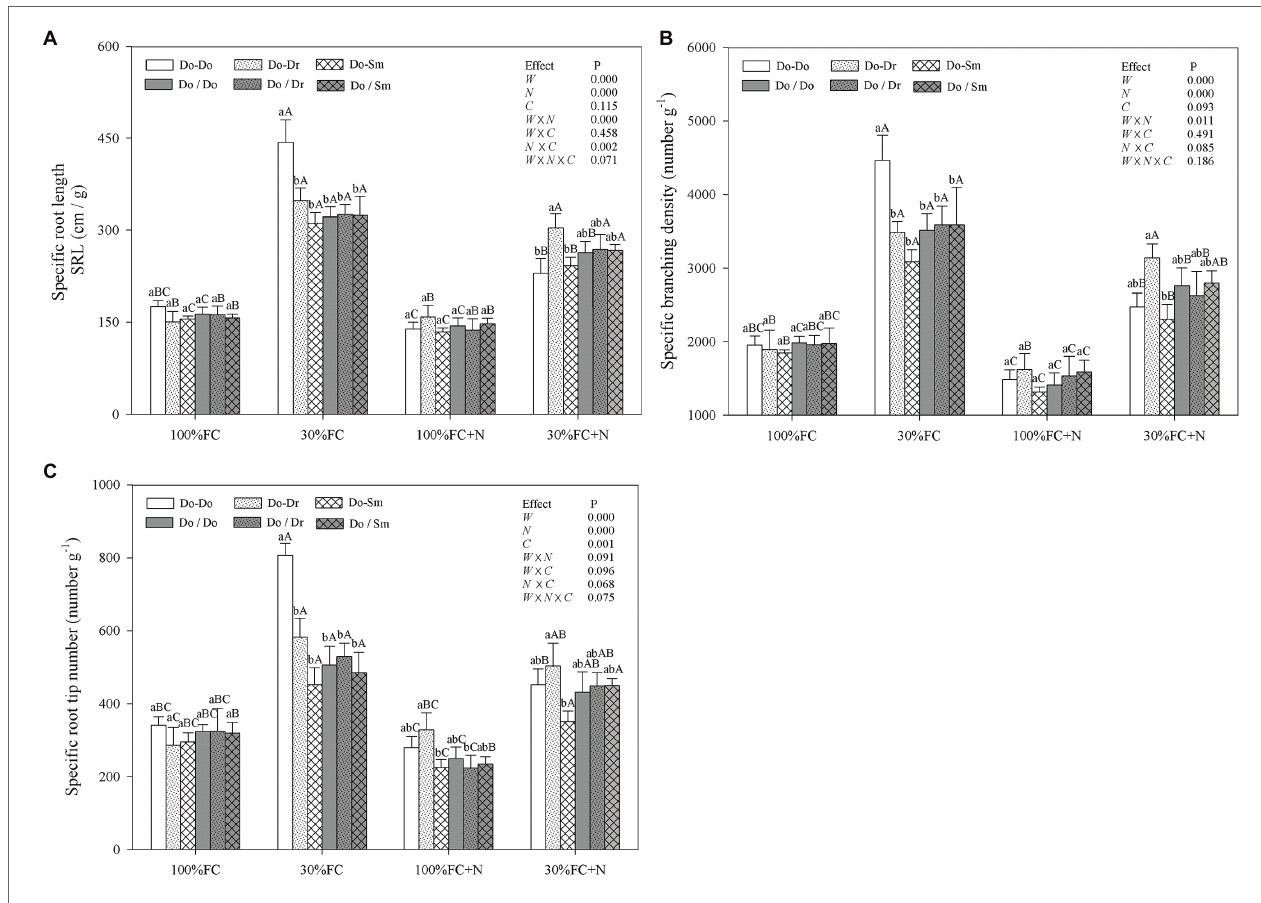
FIGURE 2 | Effects of water, N fertilization levels, and species competition models on specific root length (A) , specific branching density (B) , and specific root tip number (C) of D. odorifera . Different lowercases in each graph indicate significant difference among different competitive models (competition between D. odorifera and various N-fixing niche neighbors) under the same water and N application according to Duncan’s tests ( p < 0.05). Different uppercases in each graph indicate significant difference among different water and N fertilization application in the same competitive models according to Duncan’s tests. For abbreviations explanation of treatments (species competition models, water, and N fertilization), data description, and statistics are the same as shown in Figure 1